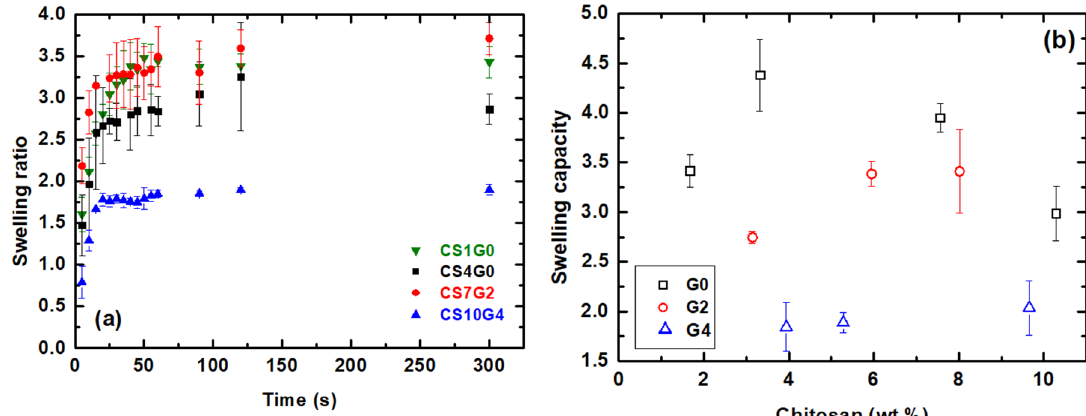
Figure 5. ( a ) Swelling ratio of CS1G0, CS4G0, CS7G2 and GS10G4 aerogels during liquid PBS absorption ( b ) Absorption capacity of CS/GPTMS-SiO2 hybrid aerogels in PBS.